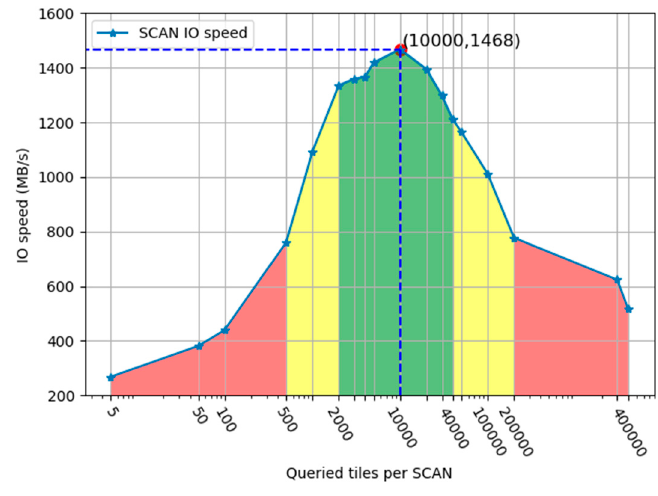
Figure 10. I / O speed with di ff erent amounts of tiles per Figure 10. I/O speed with different amounts of tiles per SCAN.